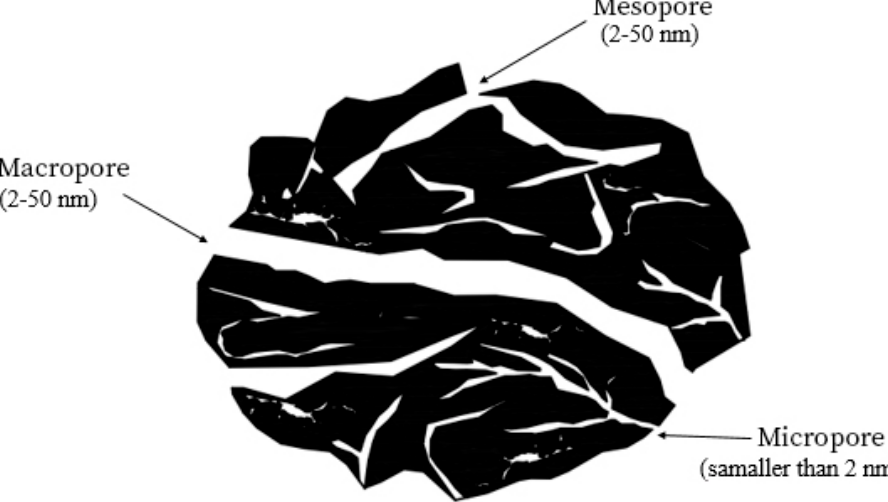
Figure 20. The structure of porous space and its naming types.